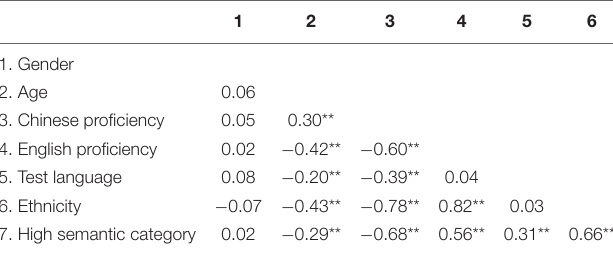
TABLE 4 | Spearman rank-order correlations among key variables.